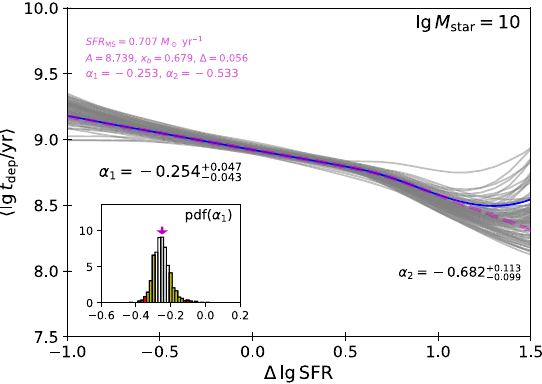
Fig. 5 Uncertainty of the molecular gas depletion time scaling. Scaling of the molecular gas depletion time with offset from the star-forming sequence for M star = 10 10 M ⊙ galaxies as predicted by the model trained on the extended xGASS/xCOLD GASS sample and a quanti fi cation of the resulting uncertainty. The model prediction is shown by the blue solid line. A double-linear function provides a reasonable approximation, see the magenta dashed curve. The resulting fi t parameters are reported in a magenta font in the top left corner of the main fi gure. Here, α 1 is the slope of lg t dep with Δ lgSFR for non-starbursting galaxies, while α 2 is the corresponding slope in the highly starforming regime. Solid gray lines show the scaling of t dep with Δ lgSFR for 100 different choices of the model parameters randomly selected from a Markov Chain Monte Carlo sampling. The inset panel shows the distribution of α 1 based on 1000 such model parameters choices with the white (white + yellow) colored part of the histogram corresponding to the 68% (95%) credibility interval of α 1 . Median values and 16th to 84th percentile ranges are listed for both α 1 and α 2